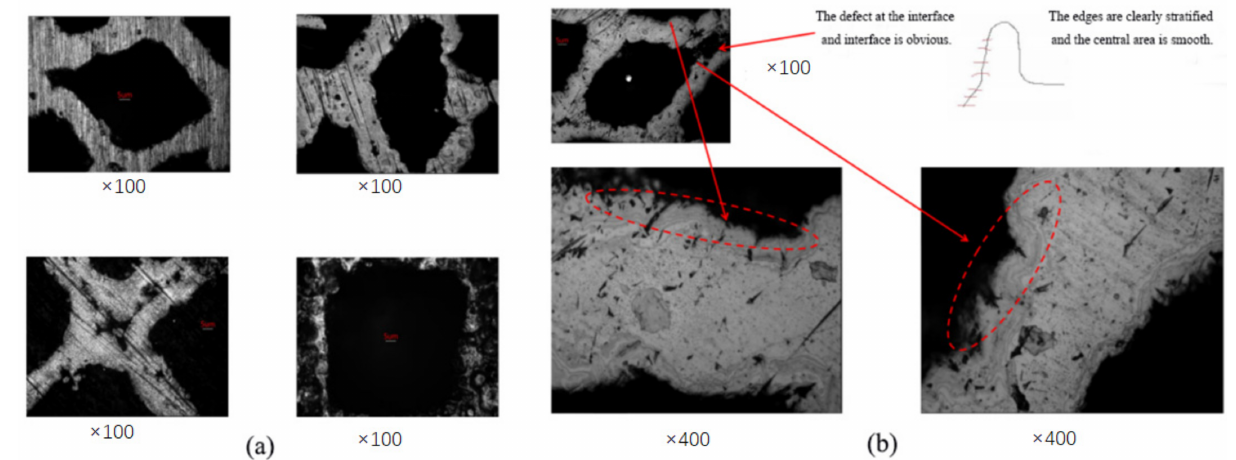
Figure 12. SEM of the section of the optimized porous stainless-steel part: ( a ) × 100. ( b ) ×